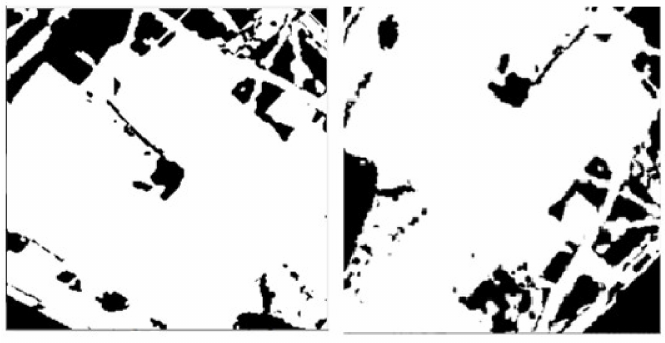
Figure 10. Training data.